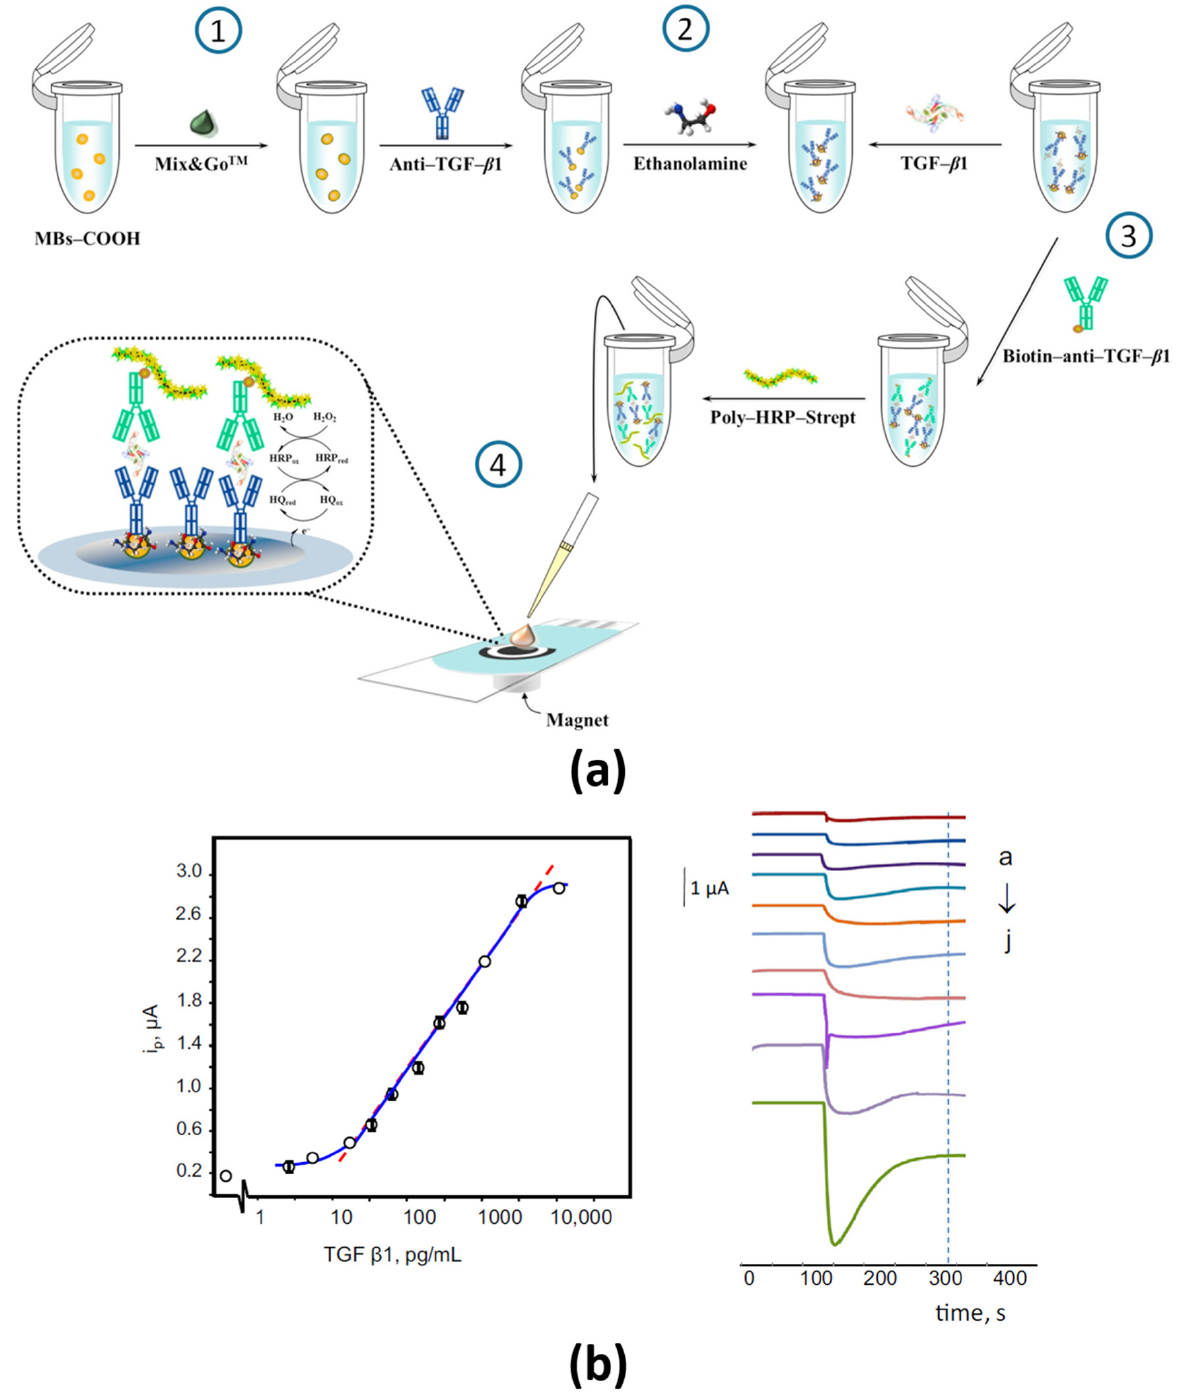
Figure 1. ( a ) Sandwich immunoassay involving covalent and targeted immobilization of CAb using the commercial Mix&Go polymer (a commercial polymeric coating that contains several metallic complexes able to bind proteins very efficiently) on HOOC-MBs, the use of an enzyme-conjugated biotinylated detection antibody with a Strep-HRP conjugate and amperometric transduction at SPCEs using the HRP/H 2 O 2 /HQ system and ( b ) calibration plot and real amperograms for TGF- β 1 standards (a–j: 0–3000 pg mL − 1 ). Reproduced from [44] with permission.